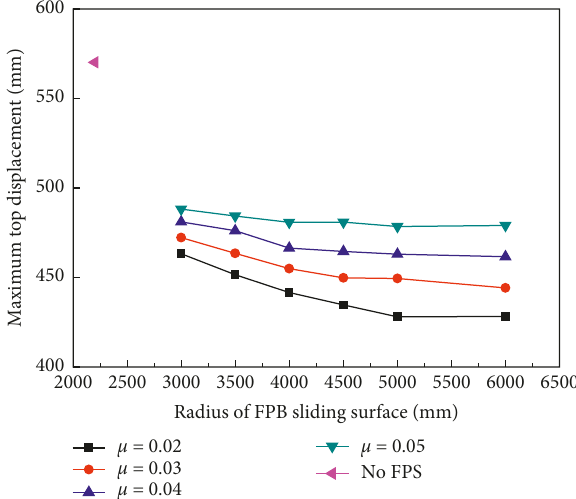
d and μ in the X Figure 25: The maximum top displacement of T4S tower with R and μ in the X direction under L6501S